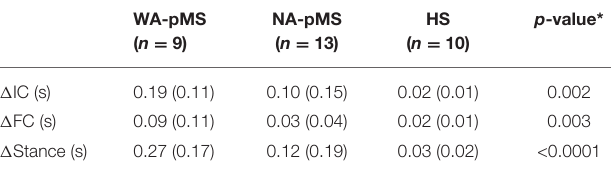
TABLE 7 | Accuracy ( 1 IC, 1 FC, and 1 Stance) scores for the IGTD